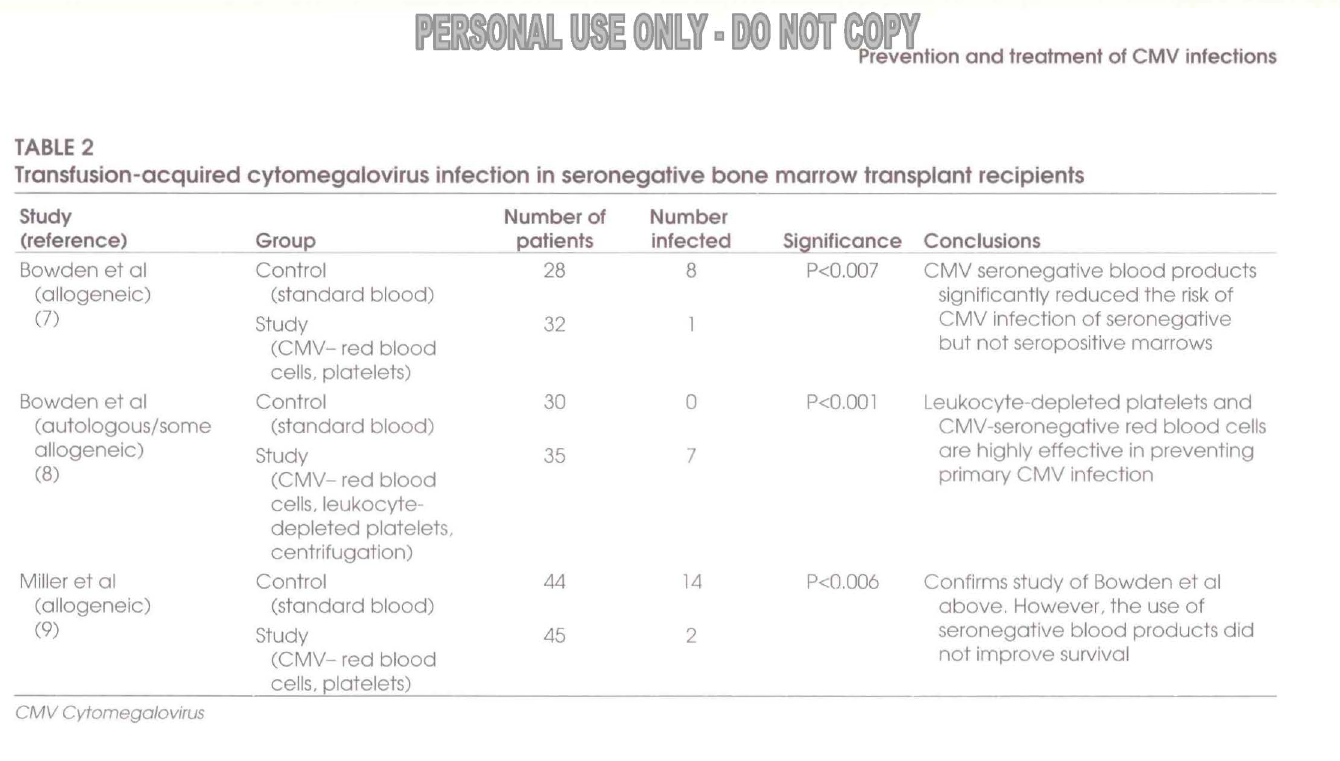
Transfusion-acquired cytomegalovirus infection in seronegative bone marrow transplant